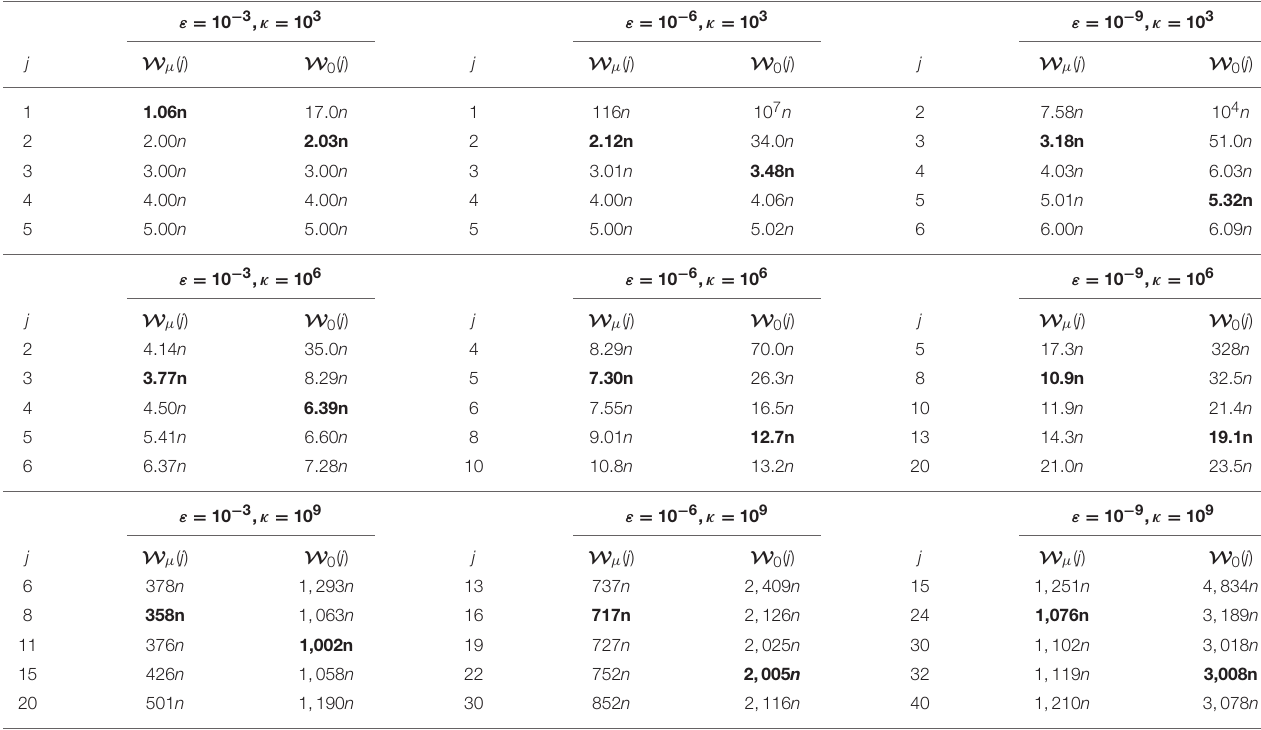
TABLE 3 | Comparison of work sufficient to solve a problem with n = 10 9 , and various values of κ and ε